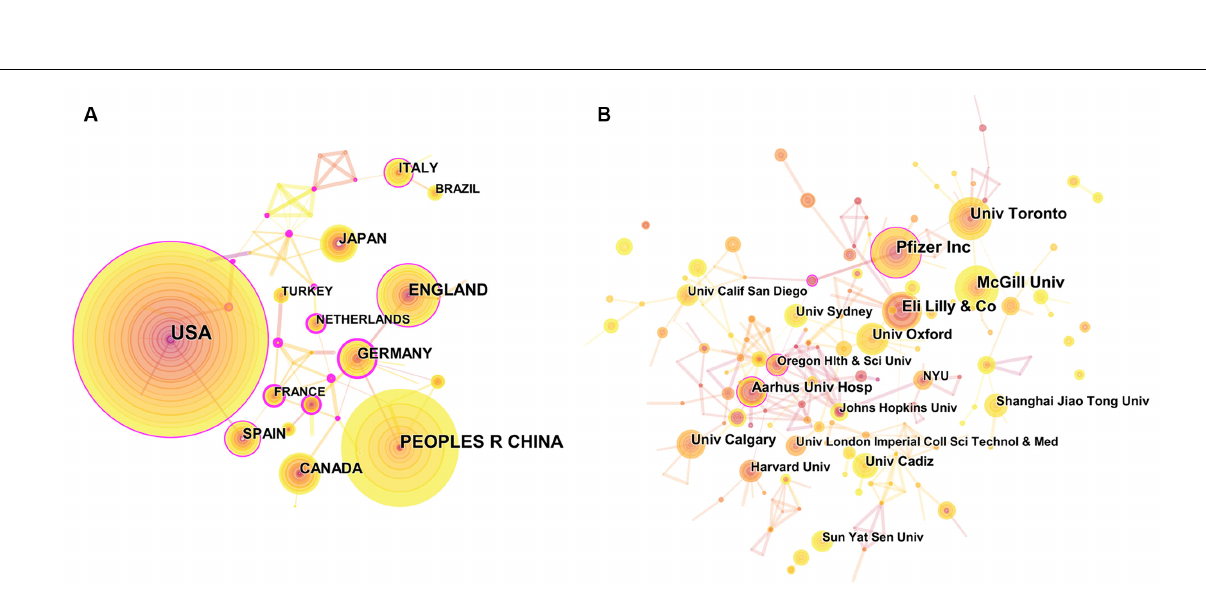
FIGURE 5 | The number of articles, citations, citations per paper, open access articles, and H-index of the top 10 countries/regions.